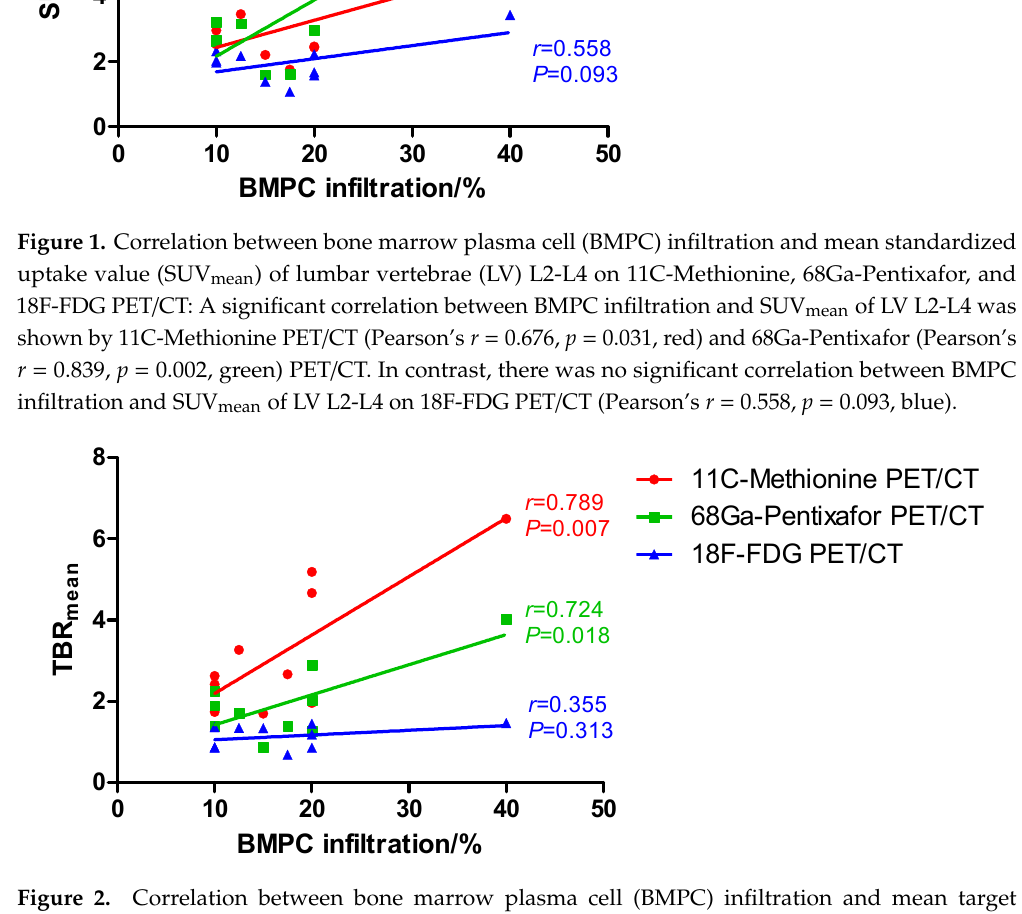
Figure 2. Correlation between bone marrow plasma cell (BMPC) infiltration and mean target to background ratio (TBR mean ) on 11C-Methionine, 68Ga-Pentixafor, and 18F-FDG PET/CT: We observed a significant correlation between BMPC infiltration and TBR mean in 11C-Methionine PET/CT (Pearson’s r = 0.789, p = 0.007, red) and 68Ga-Pentixafor (Pearson’s r = 0.724, p = 0.018, green) PET/CT. However, BMPC infiltration did not correlate with TBR mean in 18F-FDG PET/CT (Pearson’s r = 0.355, p = 0.313, blue).